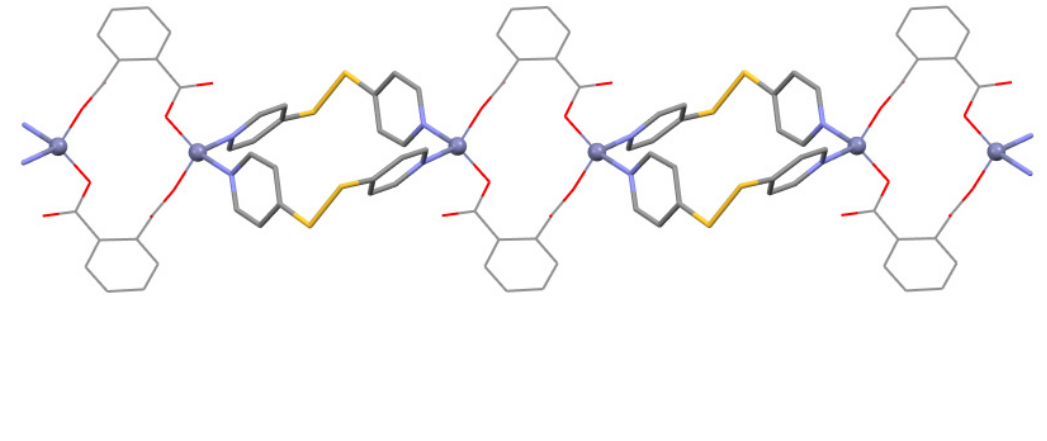
H (COO) }( μ - dtdp )·H 6 4 2